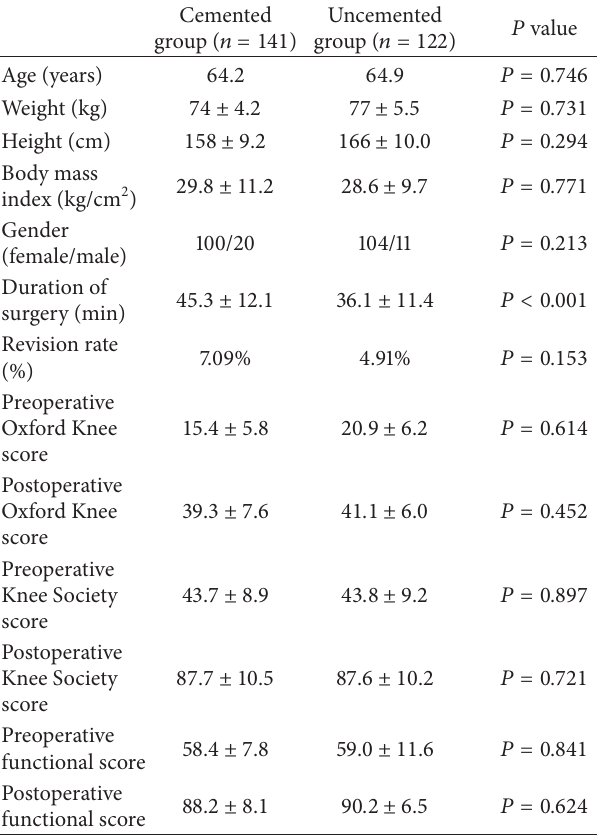
Table 1: Demographical data.